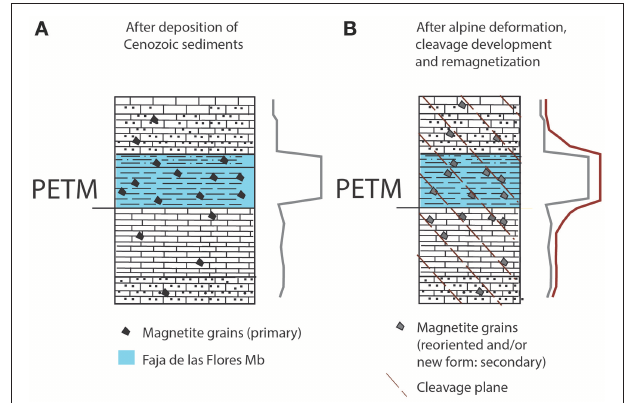
FIGURE 12 | Sketch of the concentration of magnetite grains (profile on the right of every column). (A) After deposition of the Cenozoic rocks (primary) in gray and (B) after alpine deformation cleavage development due to pressure solution and remagnetization (due to reorientation and new formation of magnetite—secondary —) in